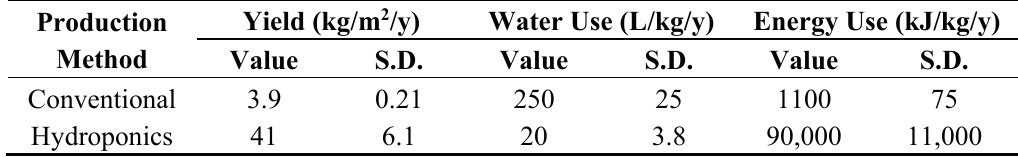
Table 1. Summary of modeled annual data with standard deviations (S.D.).